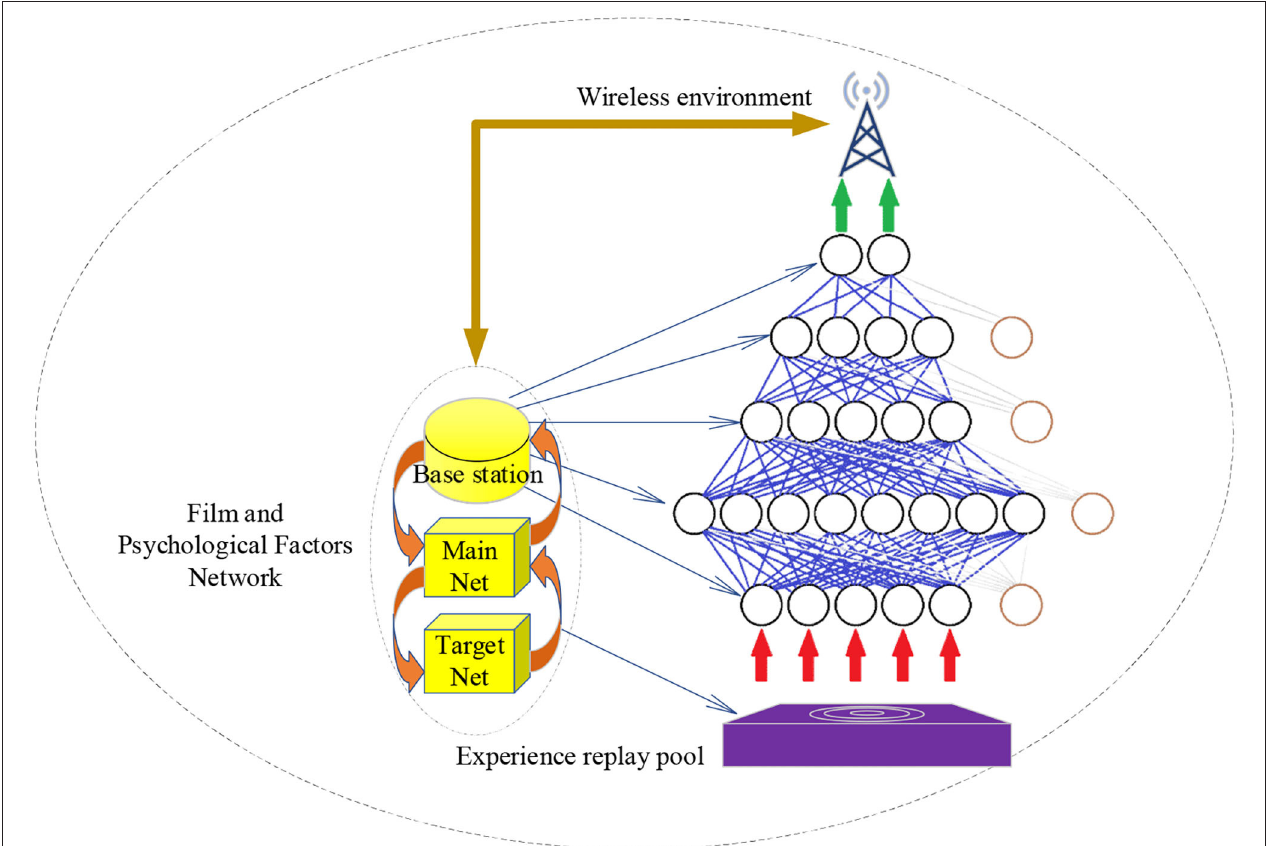
FIGURE 4 | Application architecture of